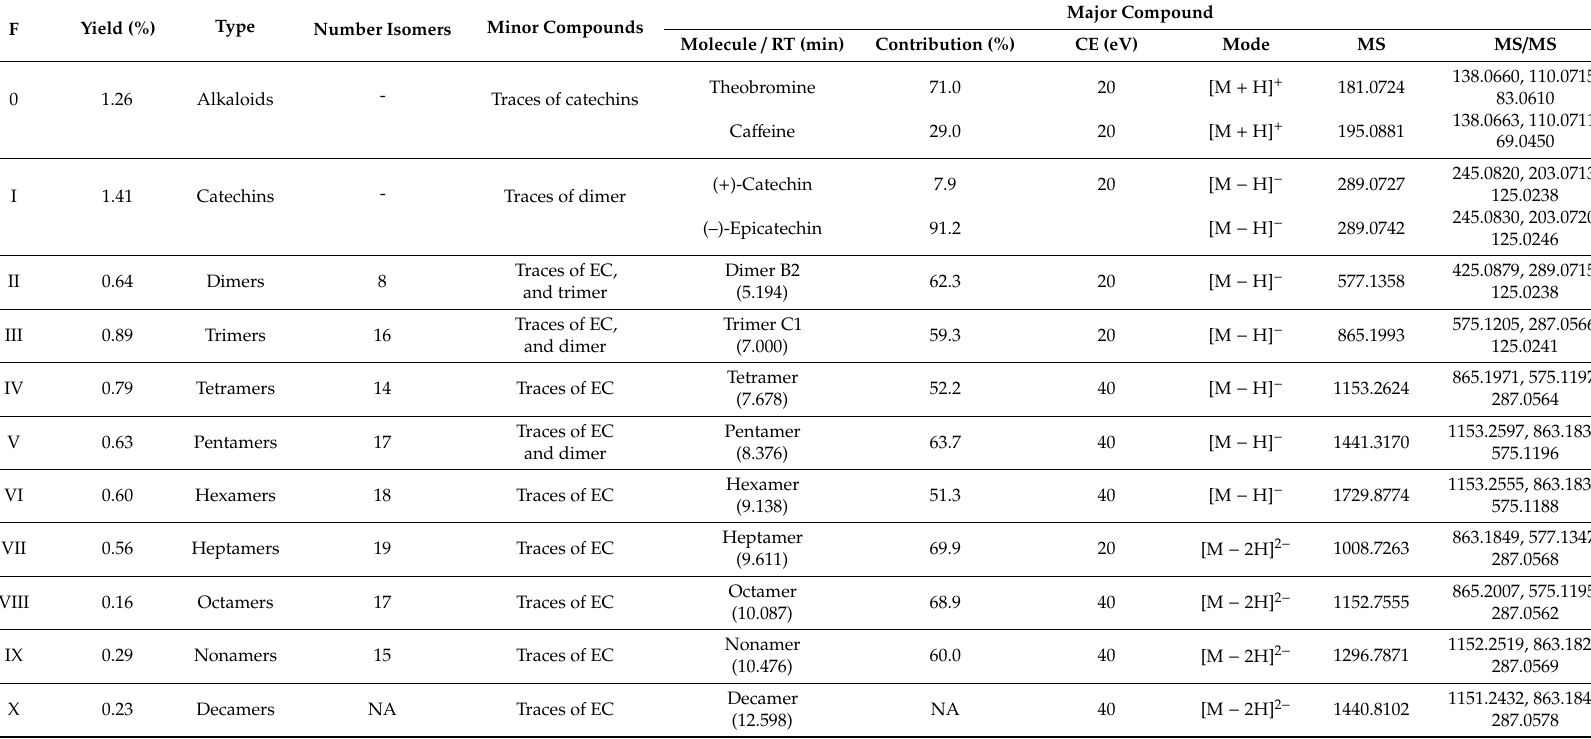
Table 2. Yield, characterization, and structural mass pattern for each procyanidin fraction from cocoa polyphenolic extract using preparative diol